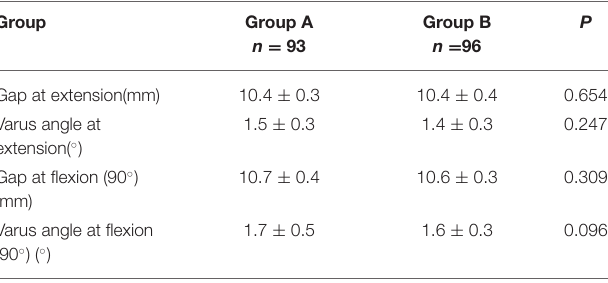
TABLE 2 | Comparison of intraoperative balance between the two groups.